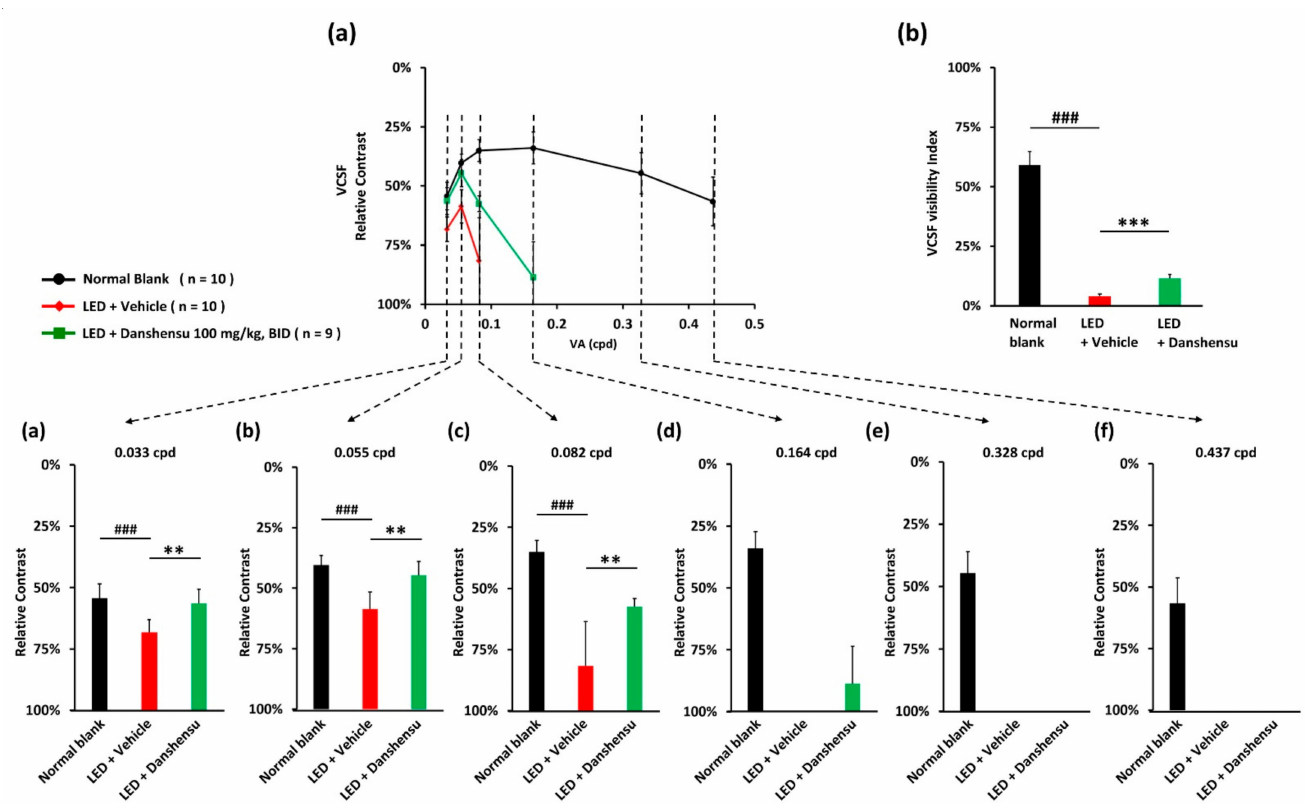
Figure 2. Protection of low spatial frequency-based visual contrast sensitivity function (VCSF) by danshensu treatment. ( a ) Representation of the inverted U-shape diagram of VCSF curve; ( b ) VCSF visibility index. Individual threshold with details represented in 0.033 cpd ( a ), 0.055 cpd ( b ), 0.082 cpd ( c ), 0.164 cpd ( d ), 0.328 cpd ( e ), and 0.437 cpd ( f ). Data are mean ± SD, Mann–Whitney U test, N.S., non-significant. ### p < 0.001, compared with the blank group. *** p < 0.001, and ** p < 0.01, compared with the vehicle